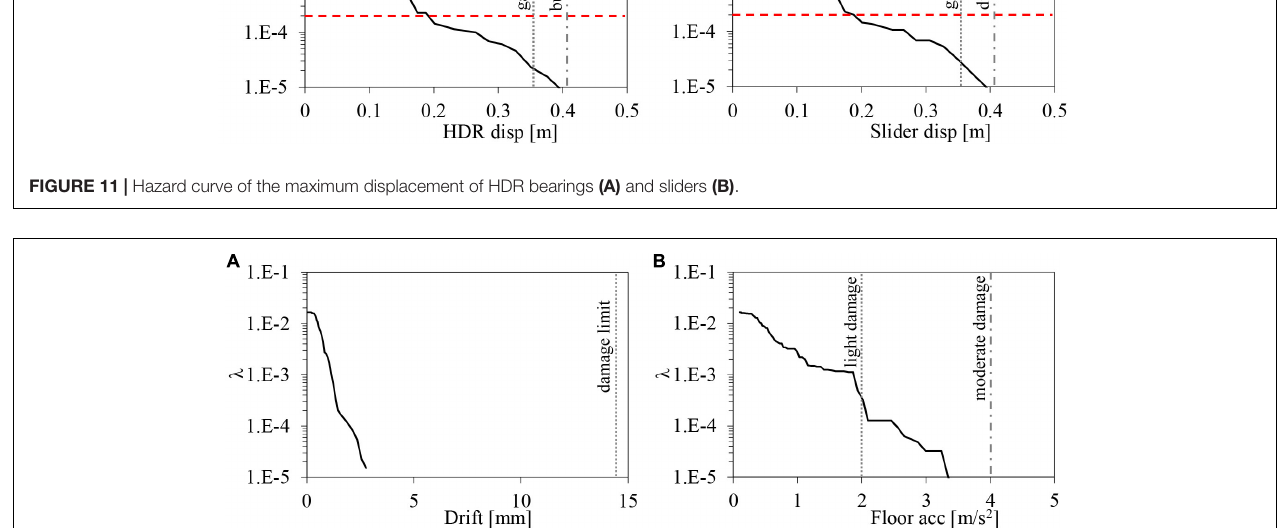
FIGURE 12 | Hazard curve of the maximum inter-storey drift (A) and the maximum floor absolute acceleration (B) .